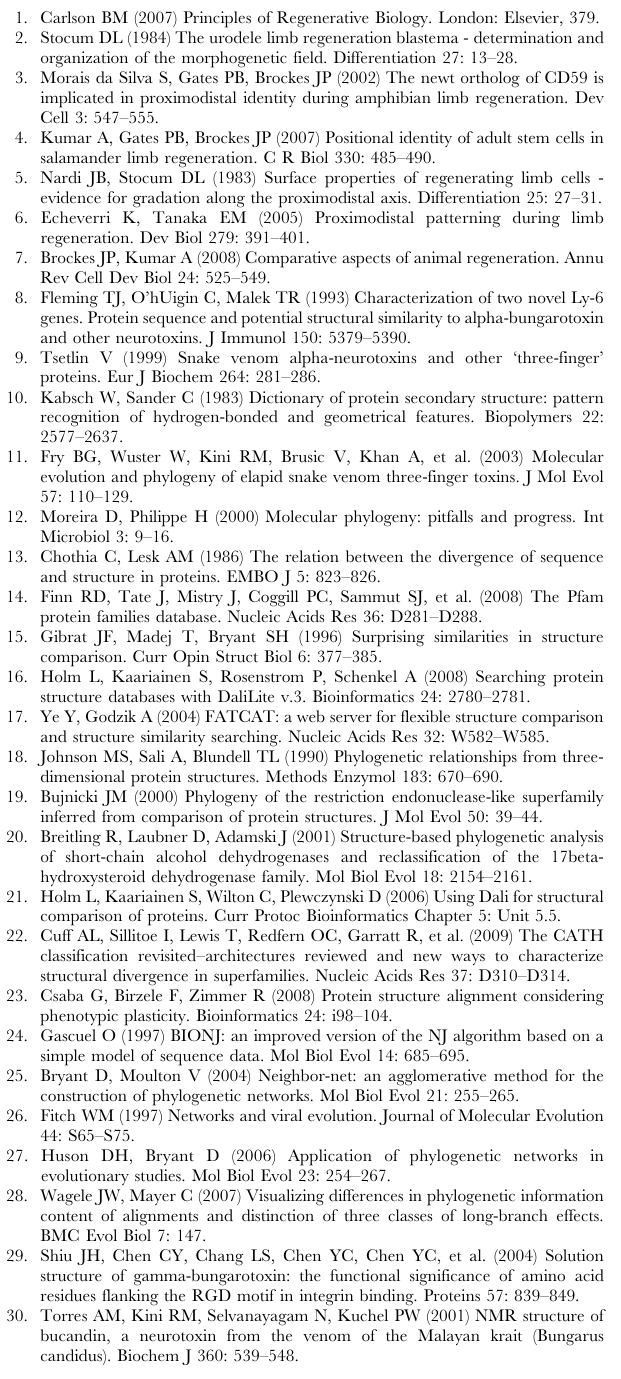
Table S3 Groupings, accession numbers, and descriptions of the sequences found in the phylogenetic tree depicted in Figure 5. Families are arranged in alphabetical order. Individual sequences within a family are arranged corresponding to a clockwise readout of the tree branches in Figure